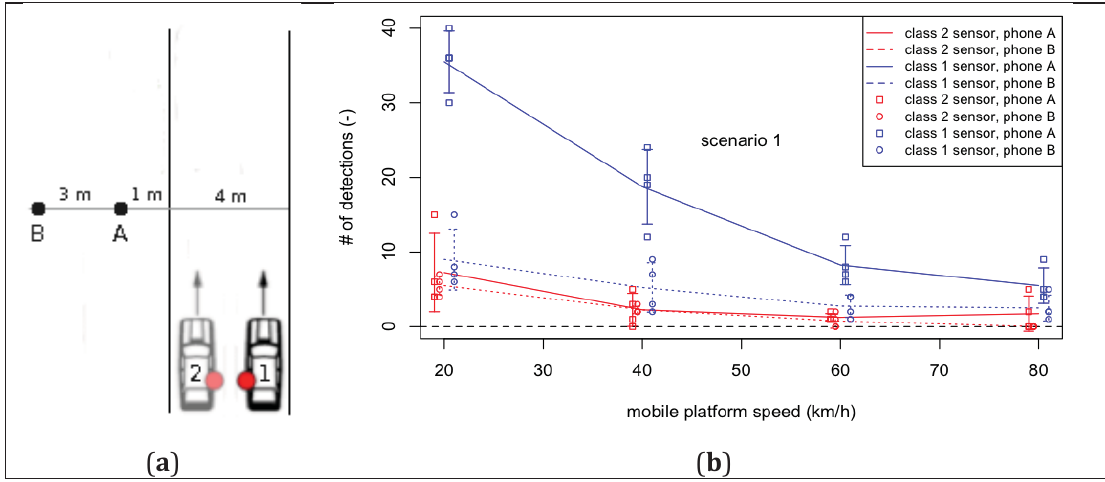
Figure 3. Mobile Bluetooth detection process investigation: ( a ) experimental setup showing both mobile phones (A, B) and the two passing scenarios (1: sensor facing phones, 2: sensor not facing phones); ( b ) effect of sensor type, speed, and phone distance (both the mean and standard deviations, as well as the individual values of all combinations are shown; both error bars and individual data points are offset from their real x-value for visual clarity); ( c ) effect of sensor placement on mobile platform at a speed of 60